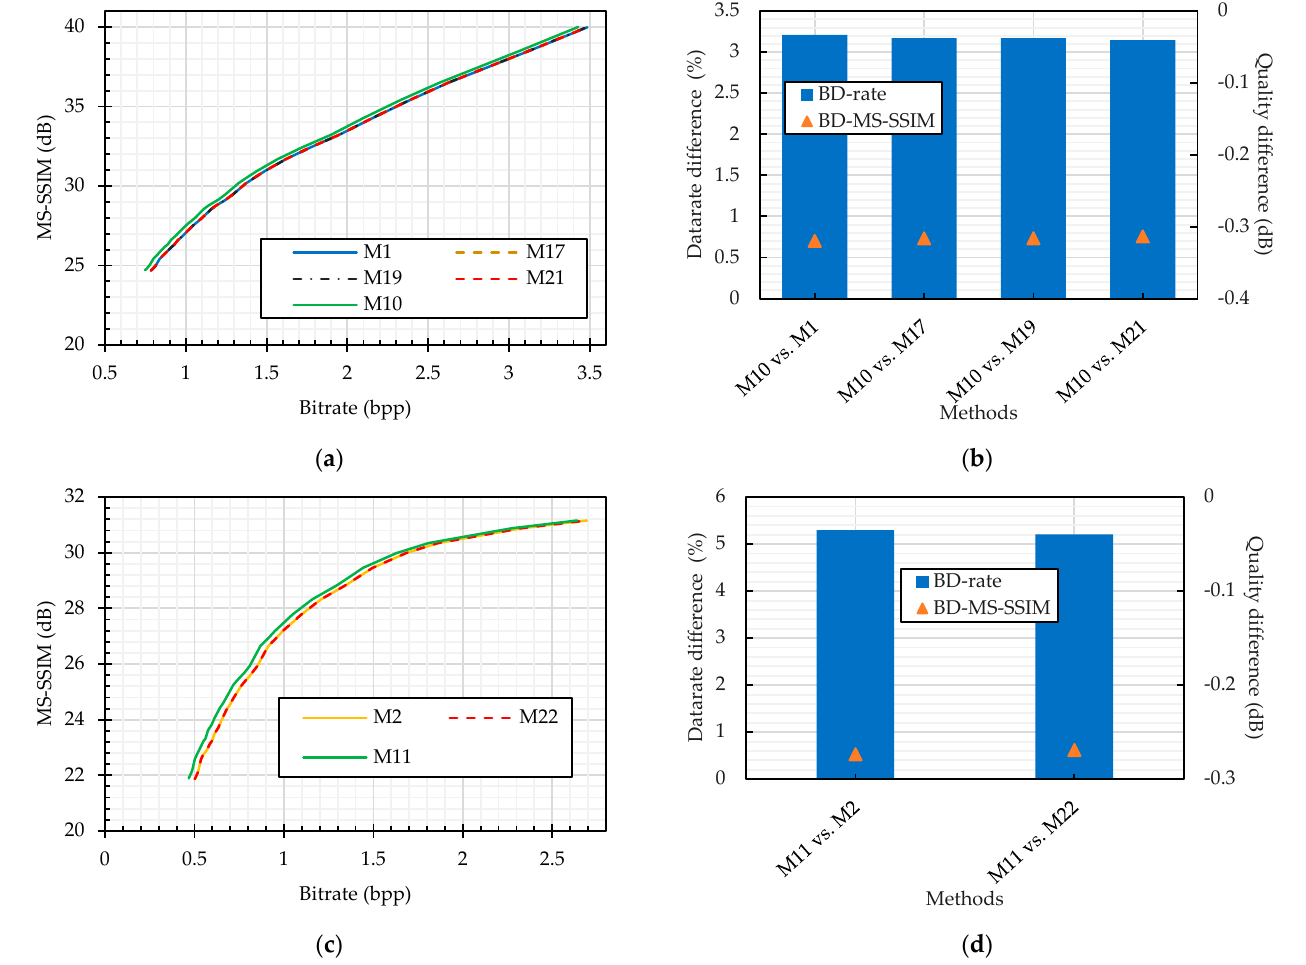
Figure 14. The JPEG compression analysis of plain and CPE images without chroma subsampling. The compression was carried out in RGB colorspace ( a ) and YCbCr colorspace ( c ); ( b , d ) are their corresponding BD-measures plots.